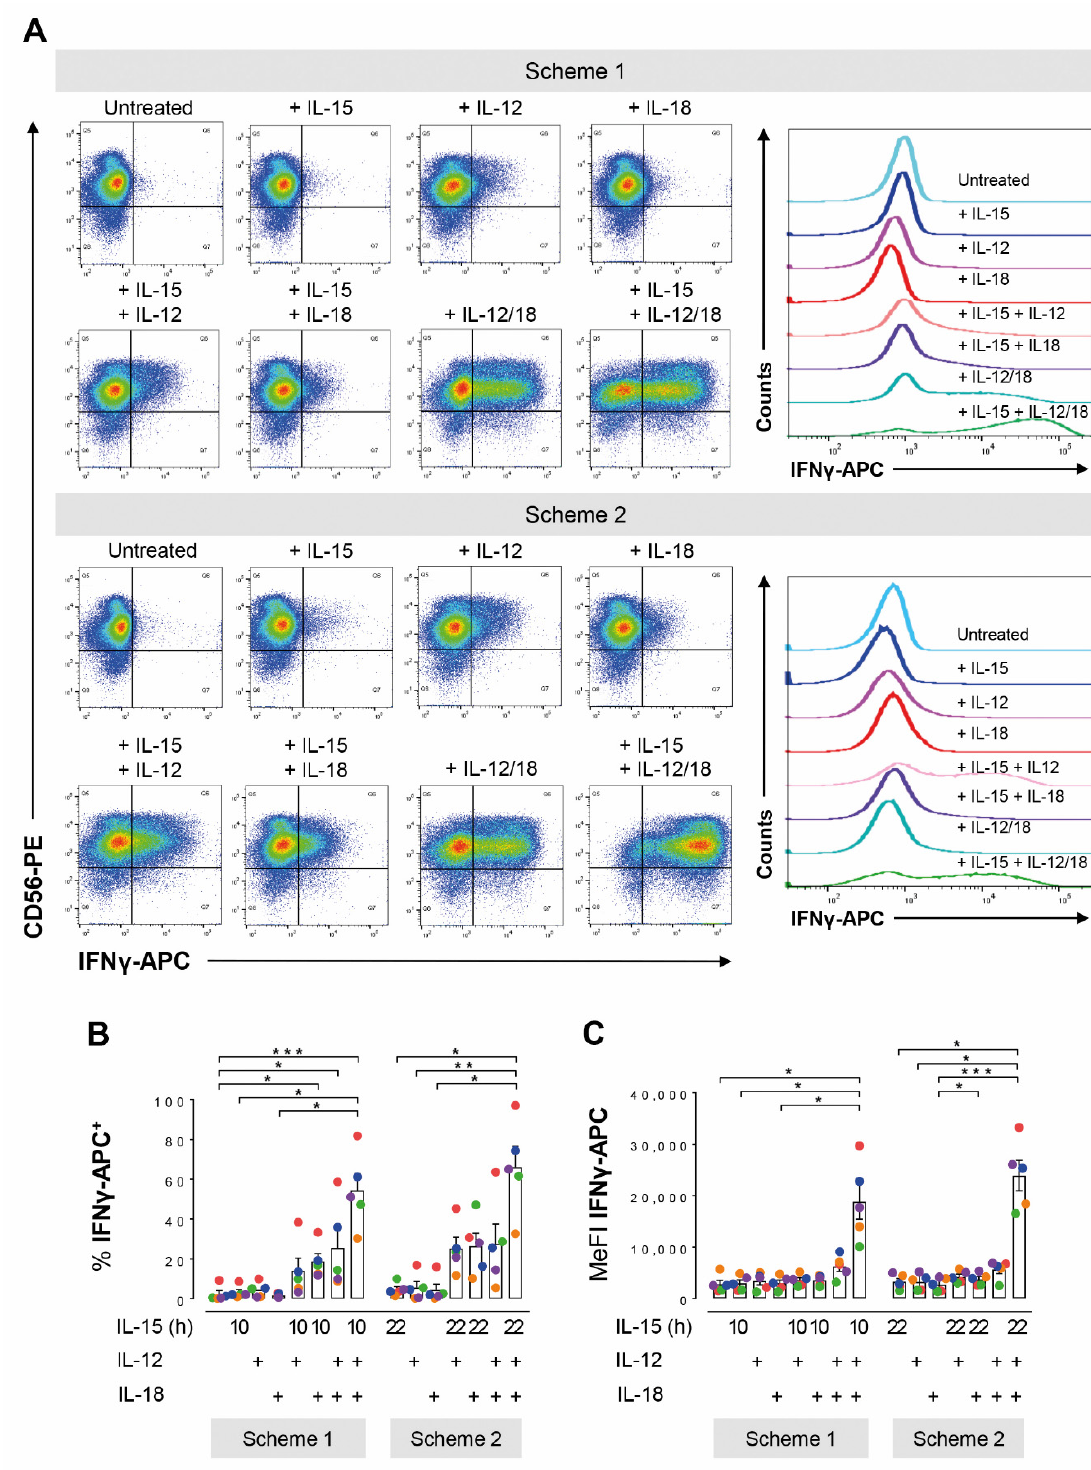
Figure2. Short-andlong-termpre-treatmentswithIL-15equallysupportIFN γ productioninIL-12 / IL-18 stimulated human NK cells. NK cells from bu ff y coats were seeded in parallel and treated according to the two schemes shown in Figure 1. Scheme 1: IL-15 was added 16 h after seeding for another 10 h. IL-12 and / or IL-18 were added for the final 4 h of the culture. Scheme 2: Cells were cultured for 22 h with IL-15 present from the beginning and IL-12 and / or IL-18 were added for the final 6 h. ( A ) CD56-PE versus IFN γ -APC dot plots exemplify the distribution of IFN γ producing cells from one